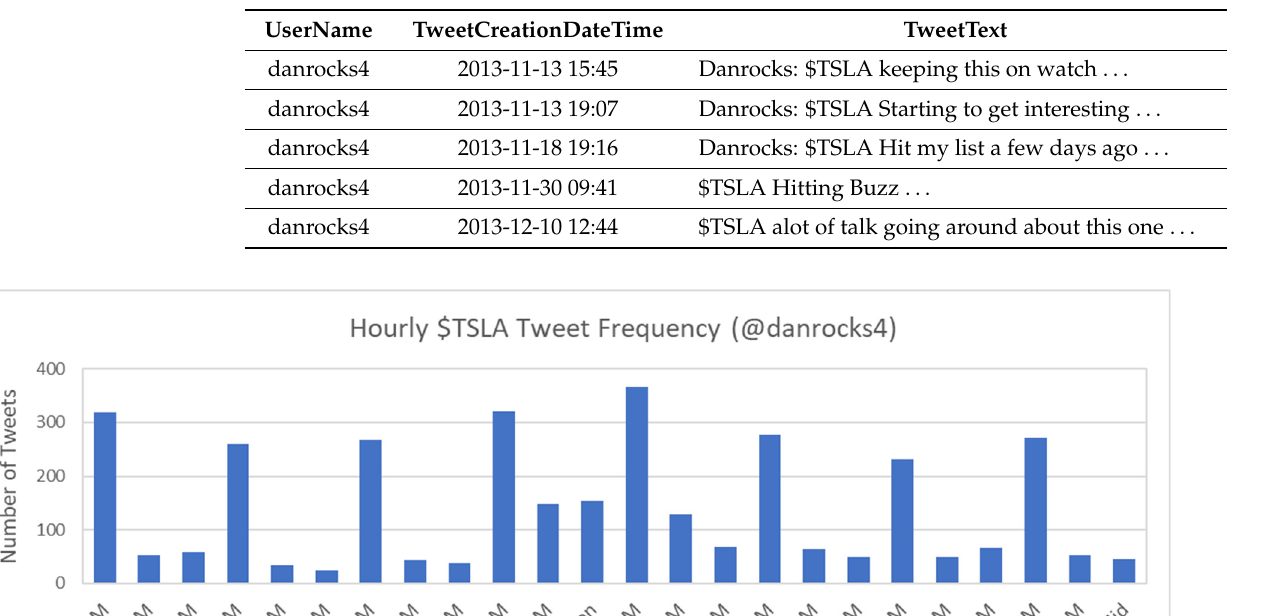
Table 2. Sample of early $TSLA tweets from one 7 November 2013 account.